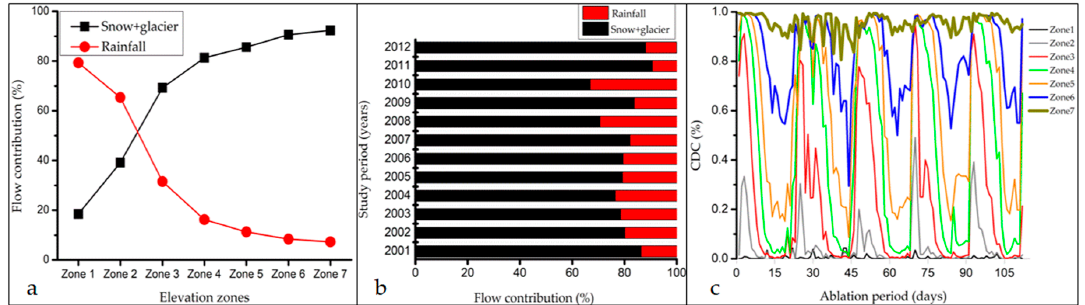
Figure 8. Zone-wise cumulative rain and snow and glacier melt contributions (%) to flow calculated by SRM over the simulation period 2001–2012.